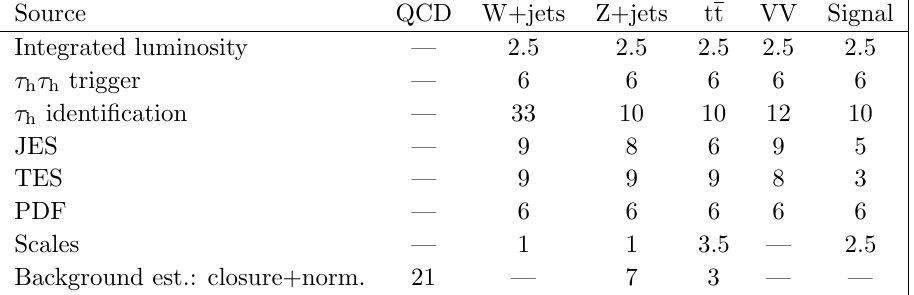
Table 1 . Summary of systematic uncertainties, given in percent. The (cid:28) h identi(cid:12)cation, JES, and TES uncertainties are also considered as uncertainties in the shapes of the m ( (cid:28) h and S MET distributions. Not included in the table are the bin-by-bin statistical uncertainties, which T increase with larger values of mass and S MET